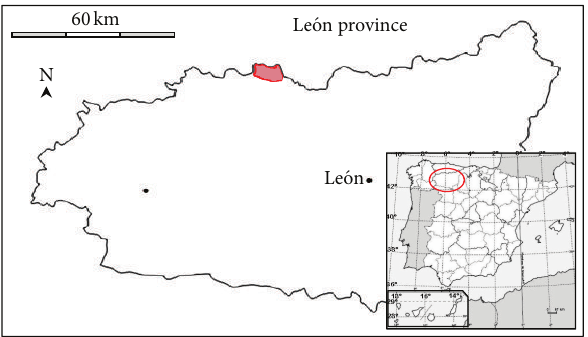
Figure 1: Map showing the location of sampled population of Gentiana lutea L. var. aurantiaca .